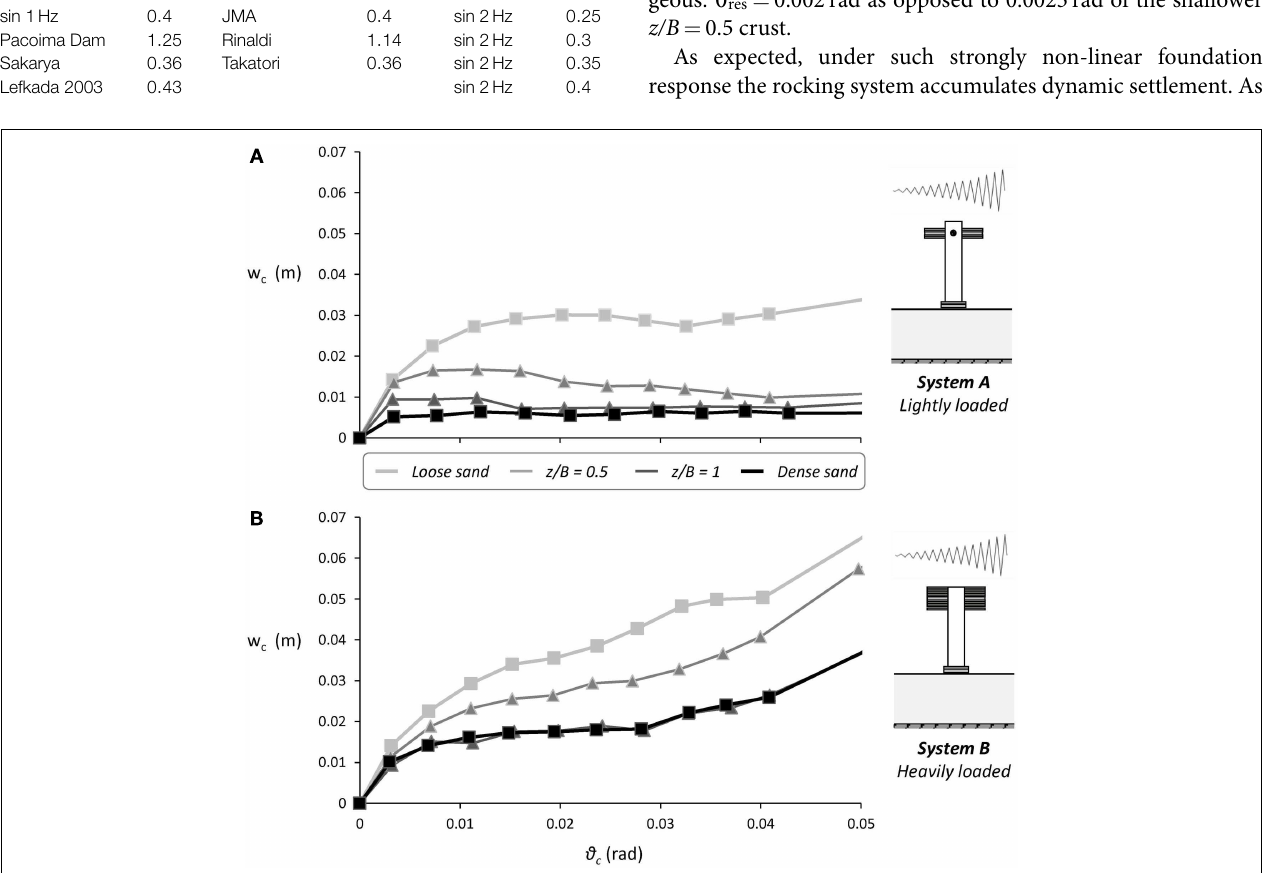
FIGURE 6 | Slow-cyclic pushover tests results . Settlement per cycle w c as a function of cyclic rotation amplitude ϑ (A) lightly loaded System A and (B) heavily loaded System B.